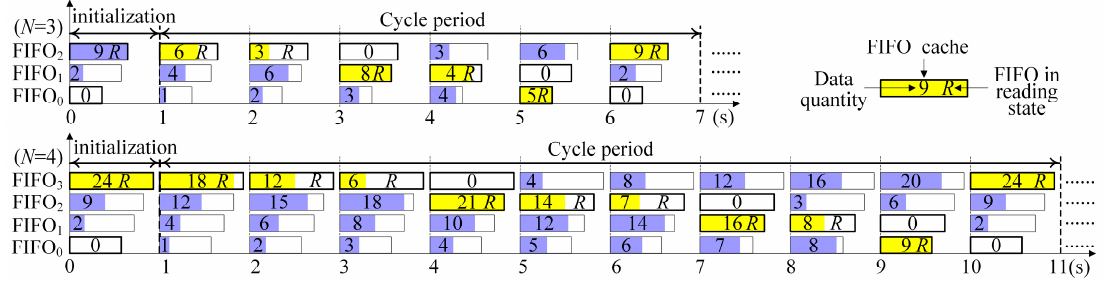
Figure 3. No time-gap switching flow chart of the N -group scanning and the N -FIFO caches shared.